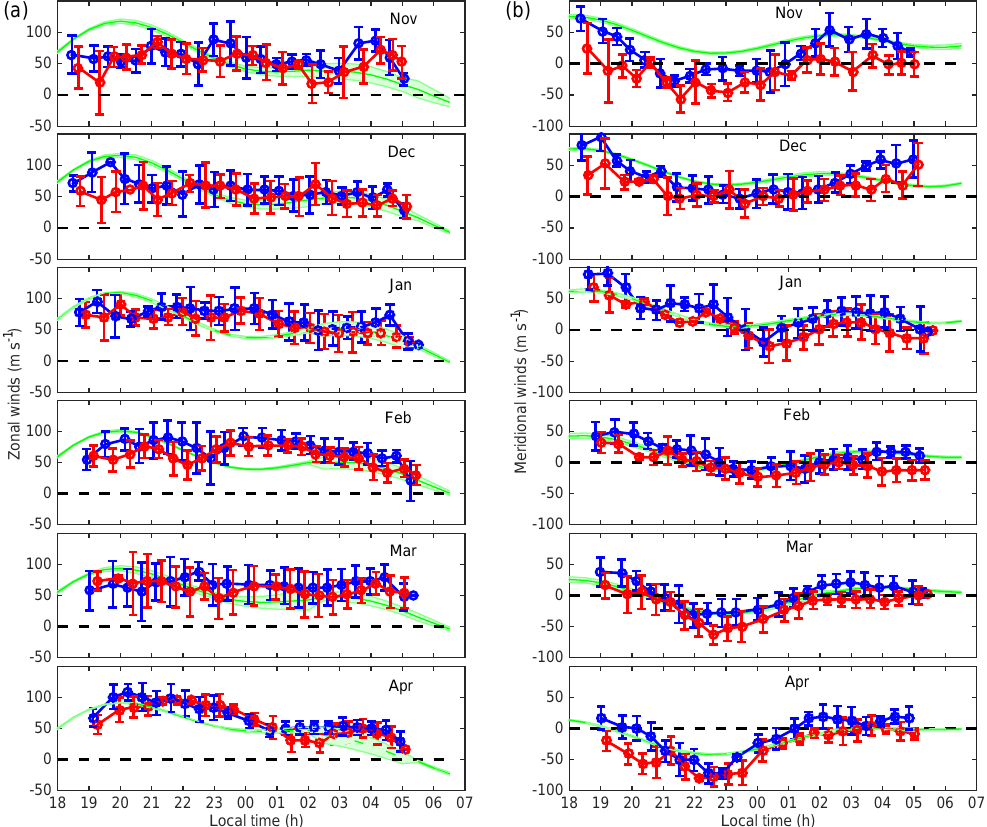
Figure 3. Monthly-averaged winds between November 2015 and April 2016 for a time bin of 30min. The left panel shows the zonal wind data for east (blue) and west (red) directions. The right panel shows the meridional wind data for north (blue) and south (red) directions. Also shown are the HWM14 model results (green) for the zonal and meridional speed variations averaged for the nights included in each month. The thickness for each model curve indicates the range of variability. The vertical bar shows the overall range of variation within each averaging